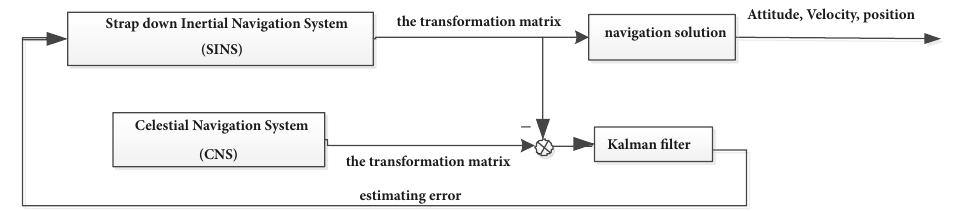
Figure 1: The structure of SINS/CNS integrated navigation